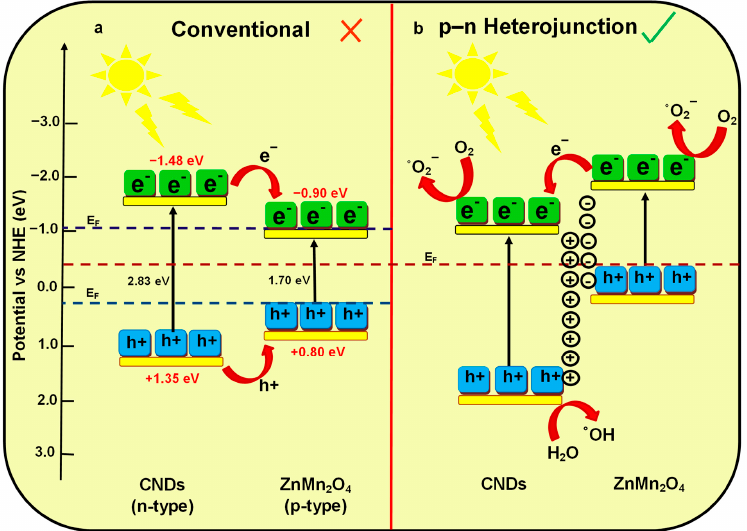
Figure 6. Photocatalytic mechanism for improved activity of CNDs/ZnMn 2 O 4 nanocomposites: ( a ) Conventional and ( b ) p-n